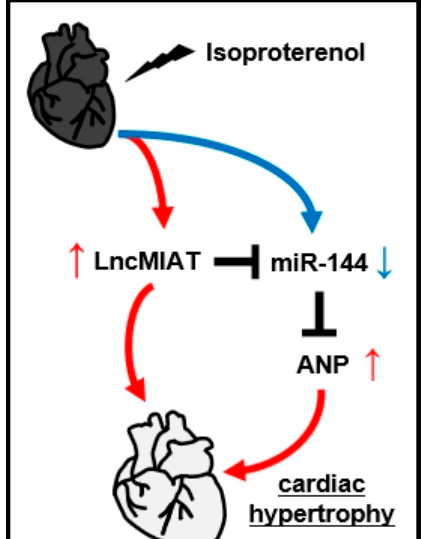
Figure 8. LncMIAT participates in isoproterenol-induced cardiac hypertrophy through miR-144-ANP.